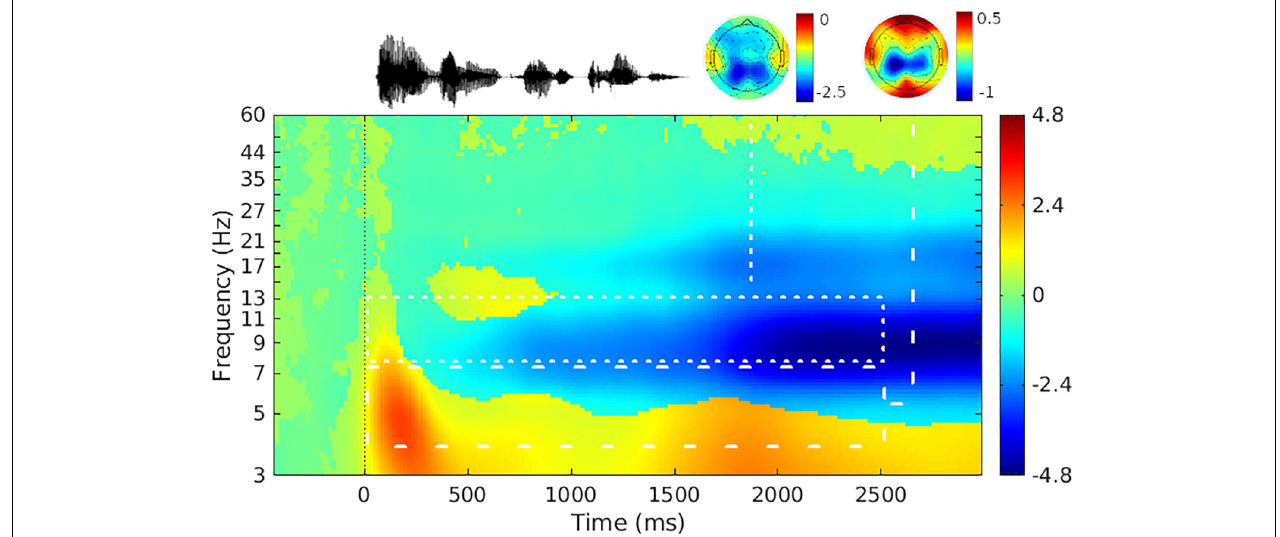
FIGURE 3 | Grand-average event-related spectral power difference from baseline. (Top left) Representative sentence waveform; (Top middle, Top right) scalp topography in the time range of 0 s before and 2.5 s after sentence onset for the alpha-band (Middle) and theta-band (Right) . (Bottom) Mean event-related spectral power difference from baseline across a trial. Color scale shows power relative to baseline in decibels [10 ∗ log 10 (average sentence interval power/average baseline interval power)] (Makeig, 1993). Time range shown on the x -axis is 0.5 s before and 3 s after sentence onset. Sentence onset is marked as time zero. White dotted and dashed lines delineate the frequency and time range analyzed for the alpha and theta bands, respectively. The mean event-related spectral power difference from baseline is collapsed across level of signal-to-noise ratio, participants, and electrodes.